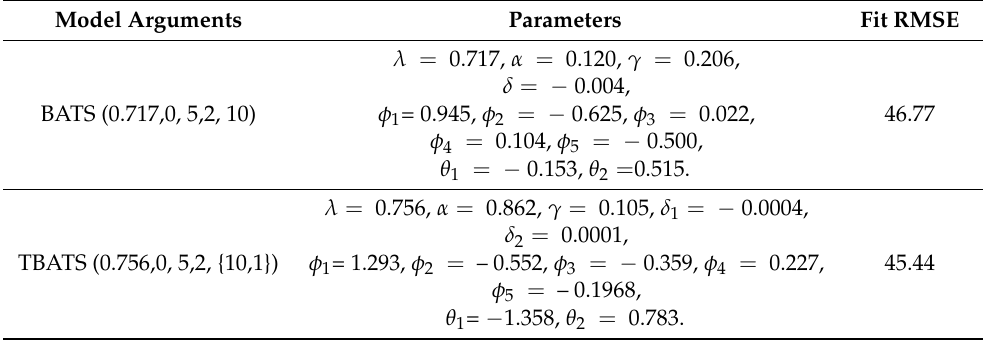
Table 3. SSM models, their parameters, and fit RMSE for fitted results. Model